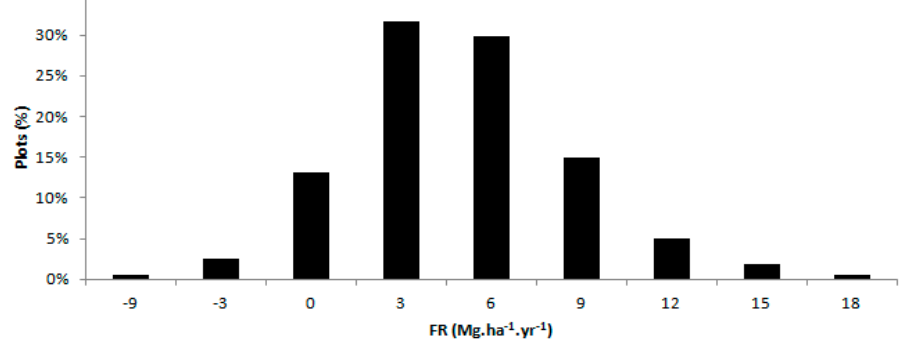
Table 5. Response to fertilization in the three regions.